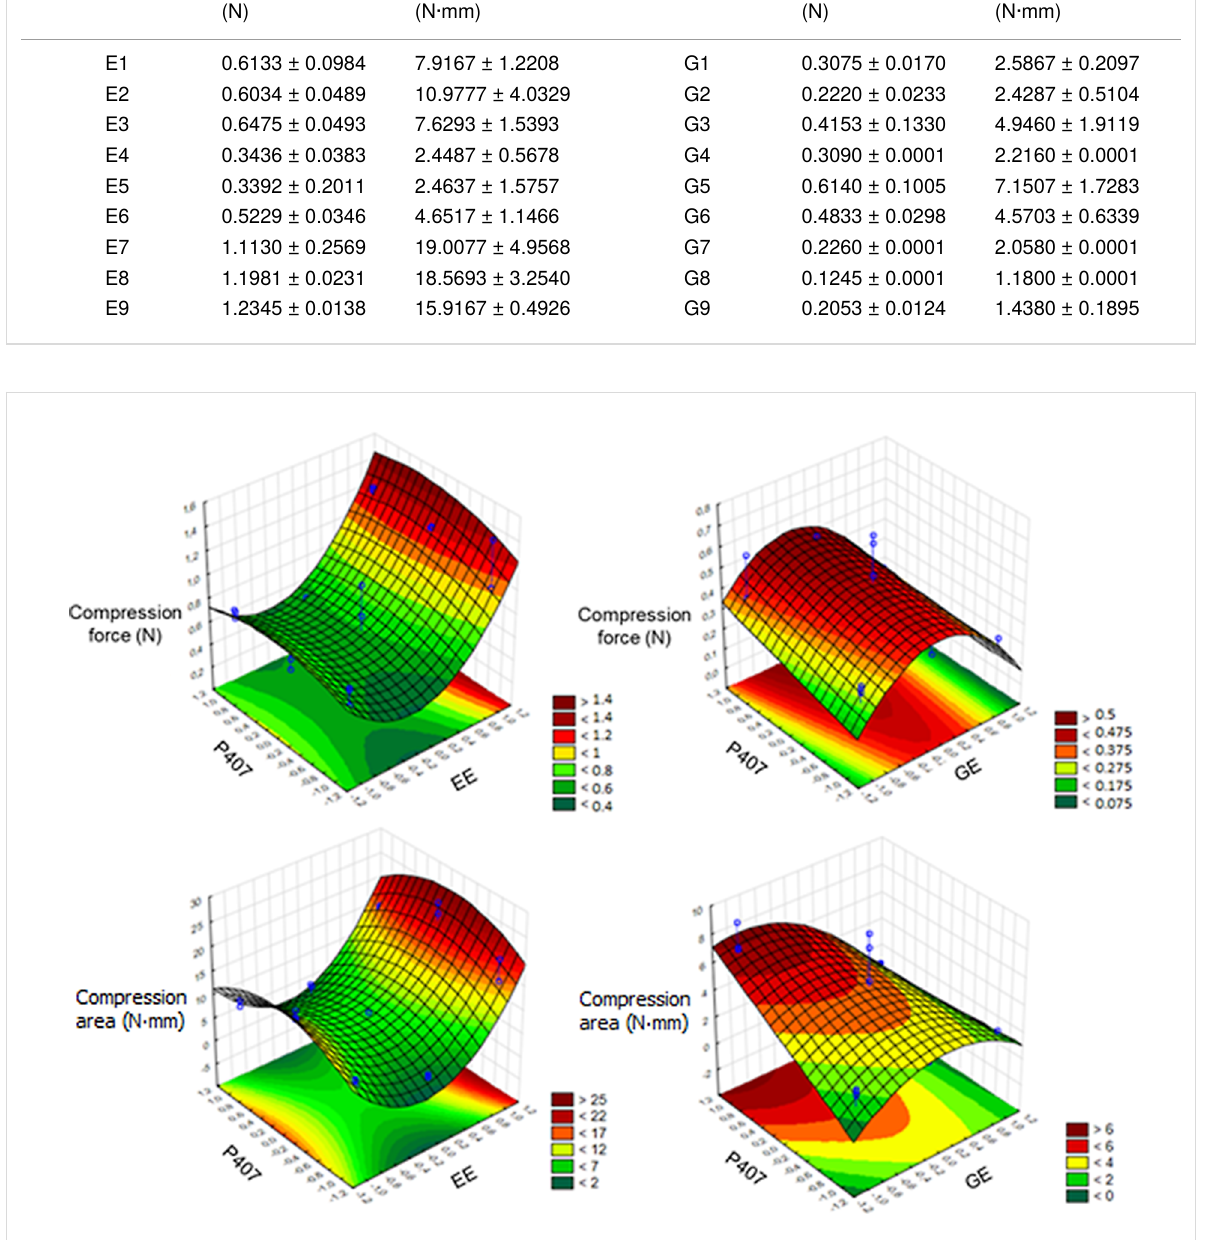
and compression area were essential for choosing the best formulations, in addition to showing the best structures for the amounts of extract and P407